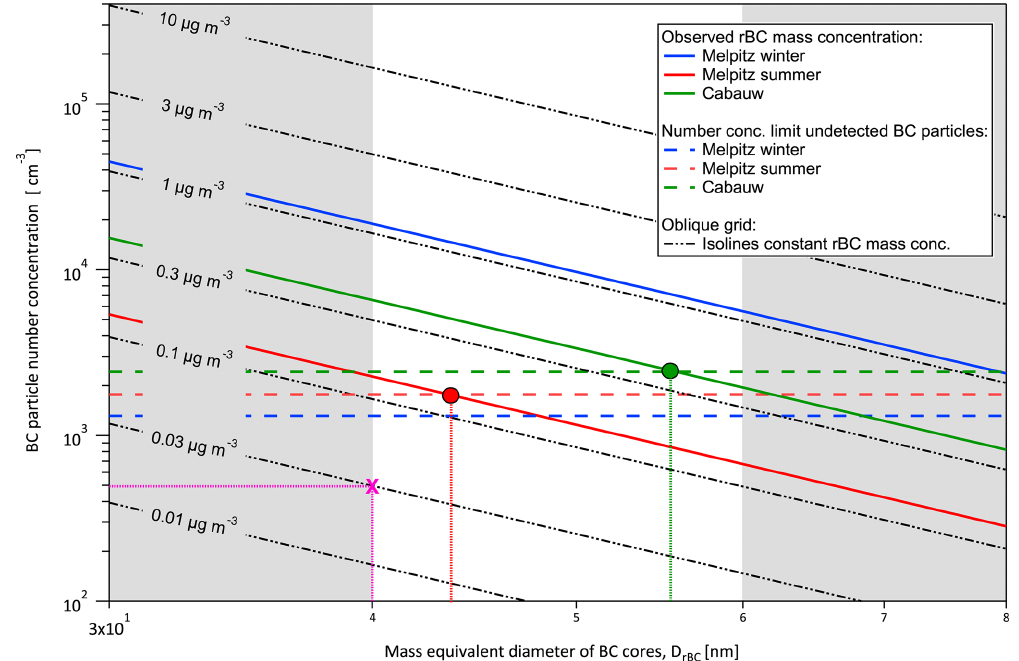
Figure 2. Relationship between rBC mass equivalent diameter, BC particle number concentration and rBC mass concentration for perfectly monodisperse BC aerosols (magenta cross and lines illustrate an example of this unambiguous relationship). The oblique dash-dotted black grid represents isolines of constant rBC mass concentration. The continuous oblique lines represent the observed uncorrected rBC mass concentrations (campaign geometric mean values). The horizontal dashed lines represent the upper number concentration limit ( n limit ), calculated as the difference between the assumed maximum and the measured BC particle number concentration. The figure can be read in two ways: the intersects of the horizontal lines with rBC mass concentration isolines provide an upper limit for the maximal undetected rBC mass concentration if the undetected mode peaks at the diameter where the intersect occurs. Alternatively, when the horizontal dashed line crosses the corresponding oblique line of the same color (e.g., red point if we consider Melpitz summer), this corresponds to a maximal contribution of rBC mass concentration in small undetected particles equal to the observed value. If we consider Melpitz summer as an example (red point) this happens for a BC mass mode of 44nm. The grey shading indicates that the modal diameter of a hypothetical mode undetected by the SP2 is expected to be between 40 and 60nm.